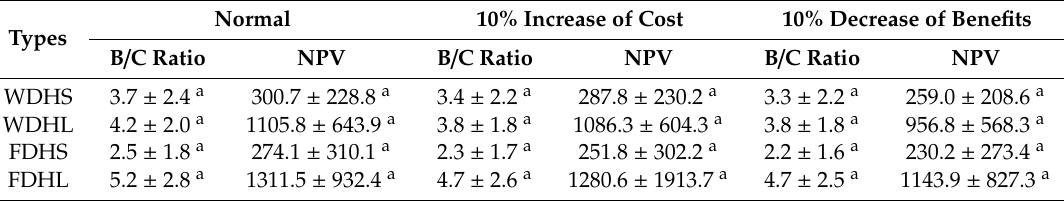
Table 6. Sensitivity of the B / C ratio and NPV on di ff erent home garden types and sizes to changes in cost and benefit components.